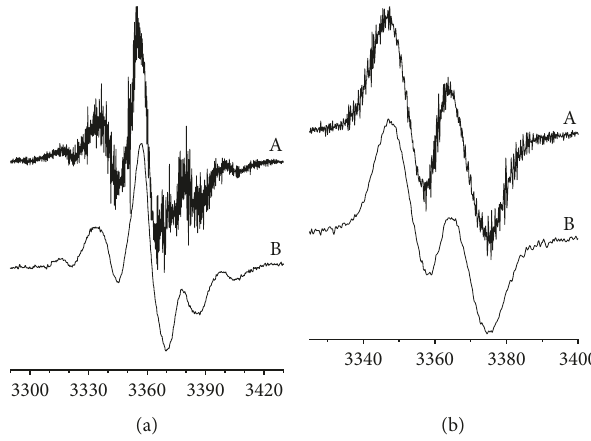
Figure 4: Difference EPR spectra of free radicals induced by UV irradiation of fibroin in weakly (77–250 K) and strongly water- coupled region (250–450). (a) A: water (77K–220 K) and B: dry (77K–250 K) forms. (b) A: fibroin in water (280 K–290K) and B: dry fibroin (380 K–400